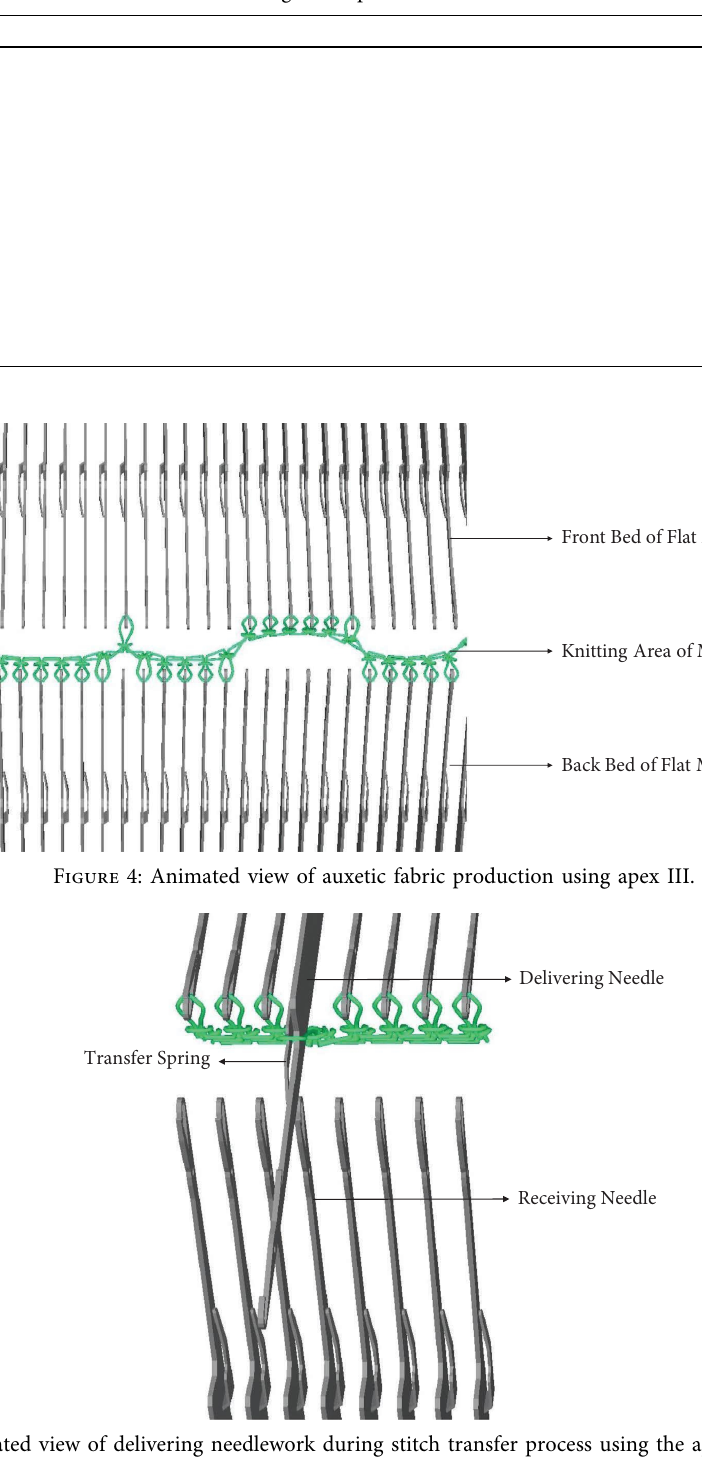
Table 2: Design of experiment of this research.